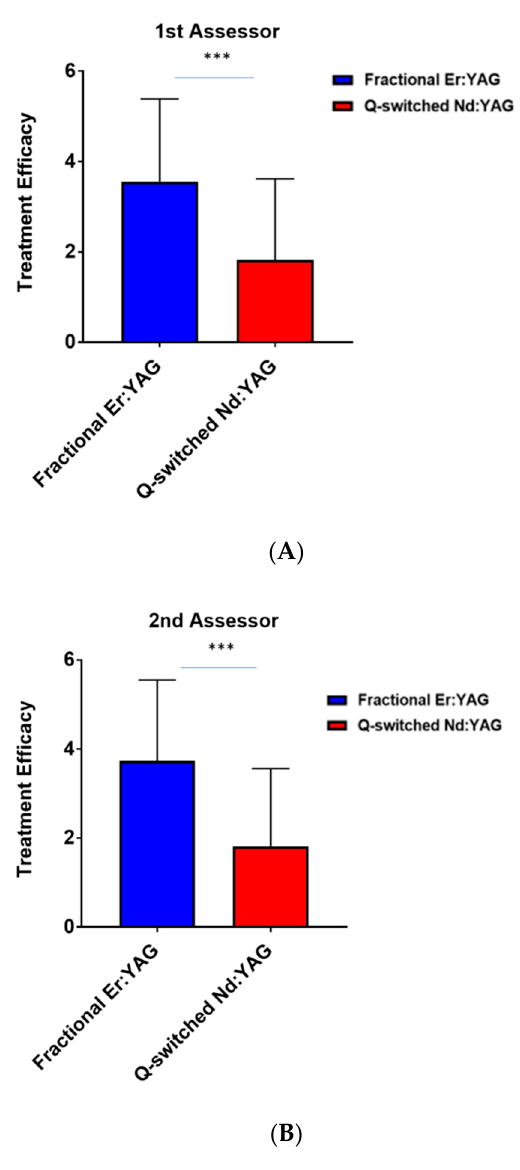
Figure 2. Treatment efficacy based on visual analogue scores of ( A ) the first assessor between Q-switched Nd: YAG (1064 nm) and fractional Er: YAG (2940 nm) lasers and ( B ) the second assessor between Q-switched Nd: YAG (1064 nm) and fractional Er: YAG (2940 nm) lasers. *** p < 0.001.